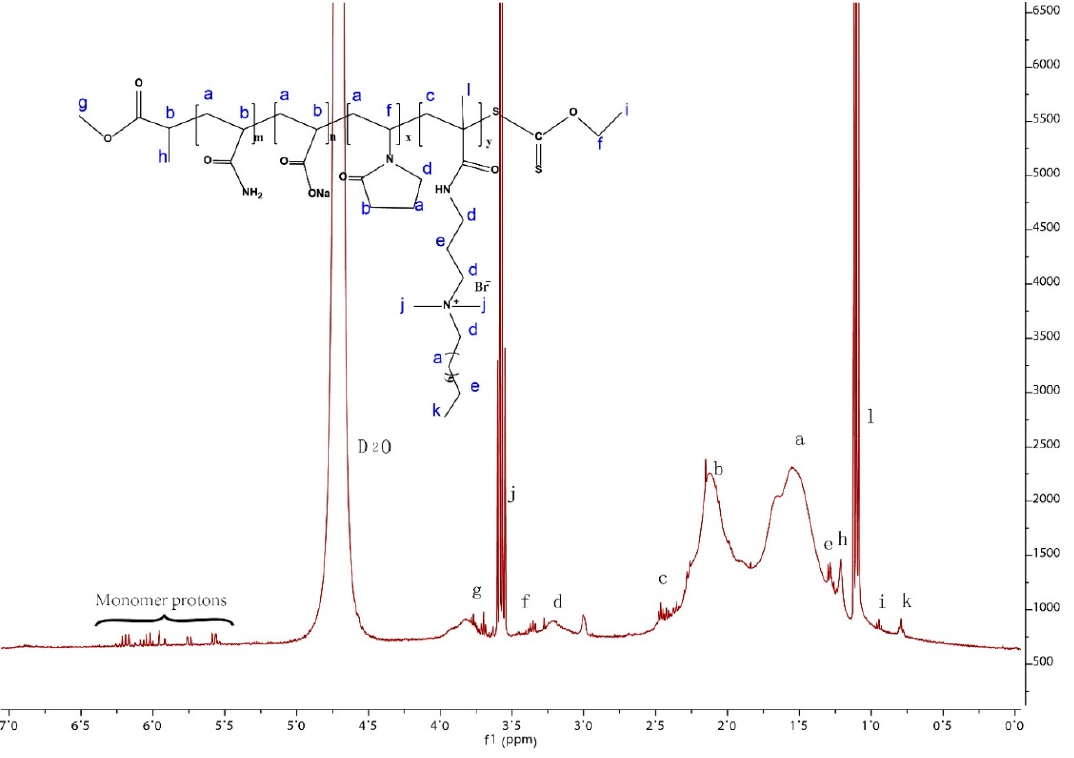
Figure 3. 1 H NMR spectrum of polymer PAANM (10% NVP).